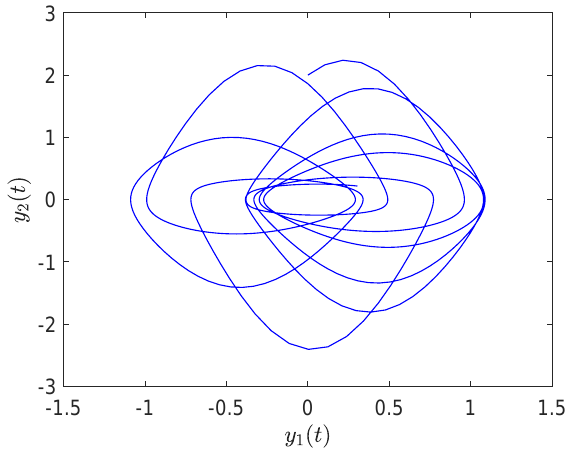
Figure 34. Phase portraits of y 1 and y 2